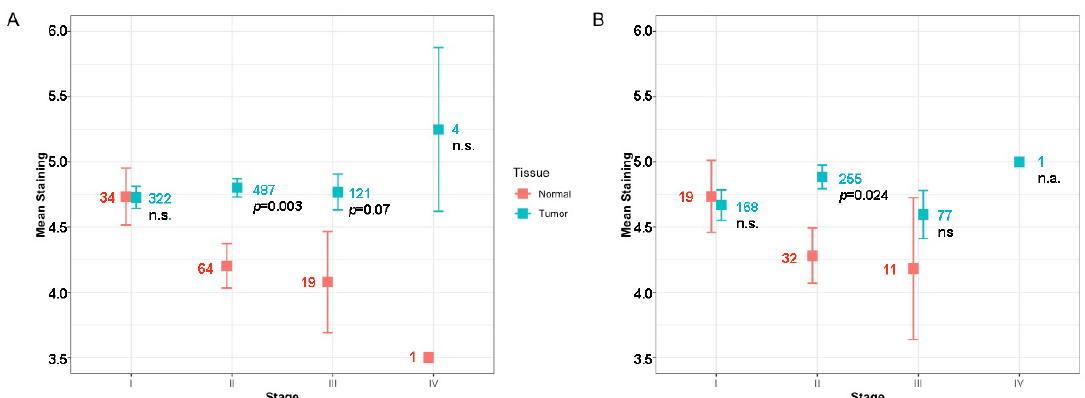
Figure 3. Comparison of mean EphB4 staining score per tumor stage in breast cancer for tumor and corresponding normal breast tissue from 934 patients ( A ). The same comparison for the 501 patients with Her2 negative tumors selected from the total cohort ( B ). Blue and red colors indicate tumor and normal tissue. Error bars represent mean ± SD. Numbers of tissues per stage are indicated with similar color code. n.s., not significant, n.a., not applicable.